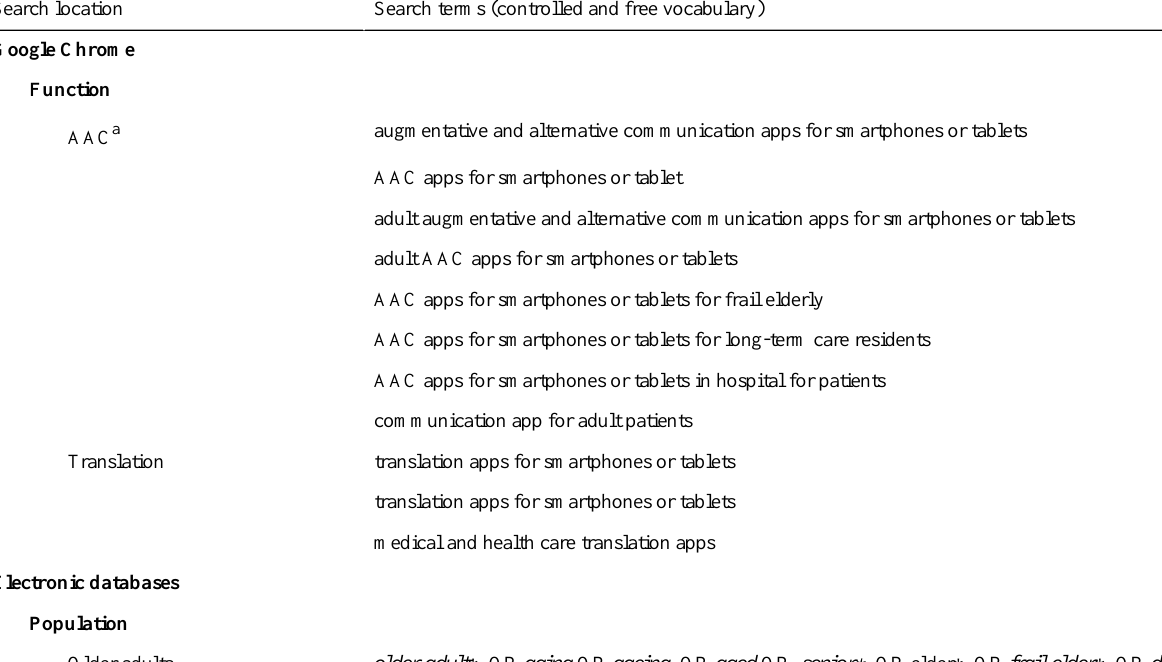
Search terms (controlled and free vocabulary)Search location